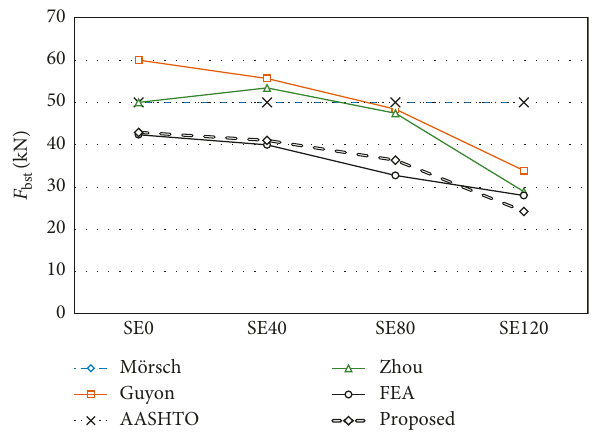
Figure 12: Evaluation of the proposed equation on the tendon